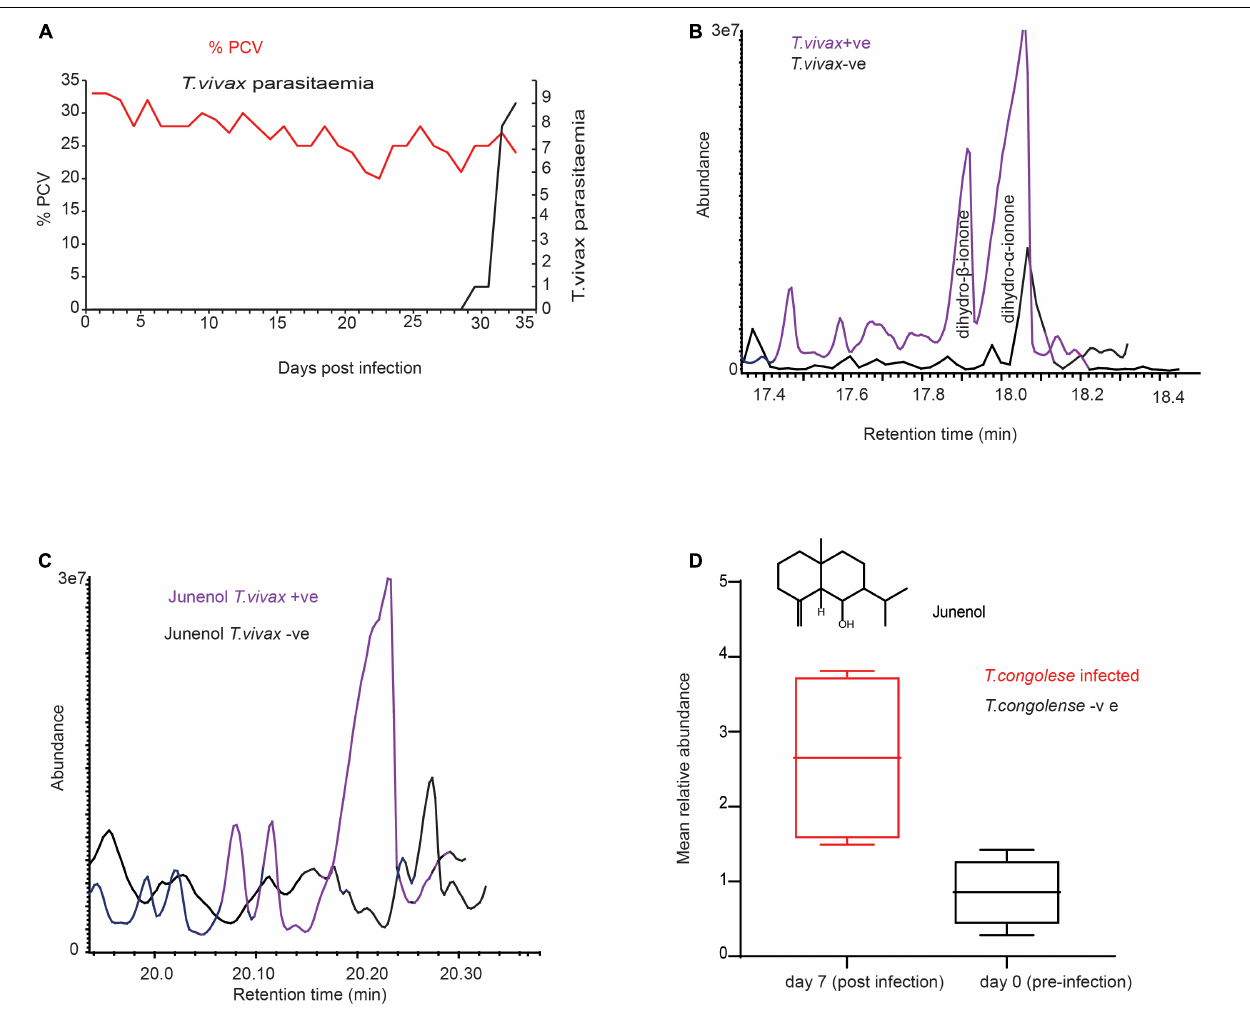
FIGURE 4 | Trypanosoma vivax infection induced similar metabolites. (A) Parasitemia and PCV change over time in T. vivax -infected cow. Left Y -axis the red dot is the measure of PCV it signifies the level of anemia from pre-infection (day 0) to 33 days post-infection, PCV < 25 considered anemic. Right Y -axis, black-dotted graph is the change in parasitemia (number of parasites/ml blood). > 10 trypanosomes per field is equivalent to ∼ > 5 × 10 5 trypanosomes/ml blood; and 1–10 trypanosome per field is equivalent to ∼ 10 4 – 5 × 10 5 trypanosomes/ml blood. (B) GC-MS profile showing dihydro- β -ionone induction and dihydro- α -ionone enhancement due to T. vivax infection, (C) GC-MS profile showing the induction of junenol due to T. vivax infection. (D) The mean signal intensity of junenol in healthy and T. congolense- infected cow urine, n = 4, paired t -test 3.96, P =